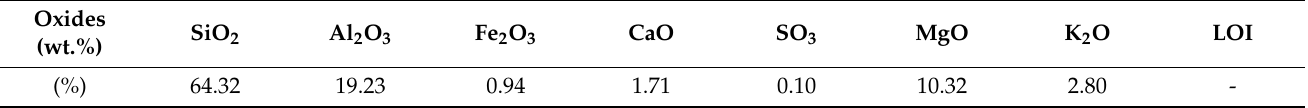
Table 2. Chemical composition of the PPR used.